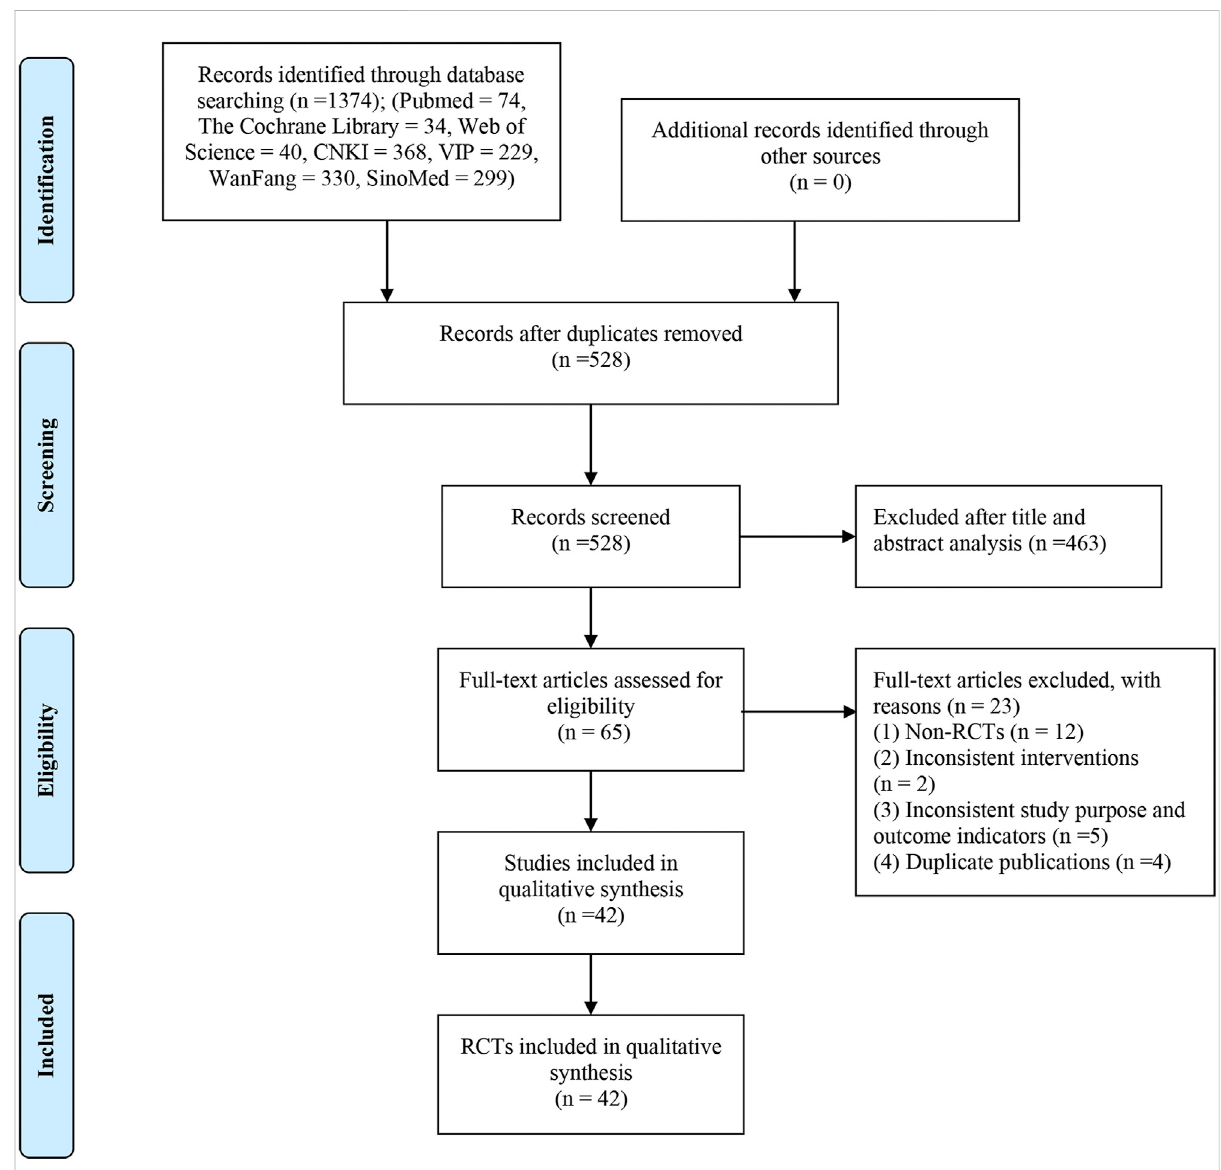
FIGURE 1 Flow diagram of study selection and identi fi